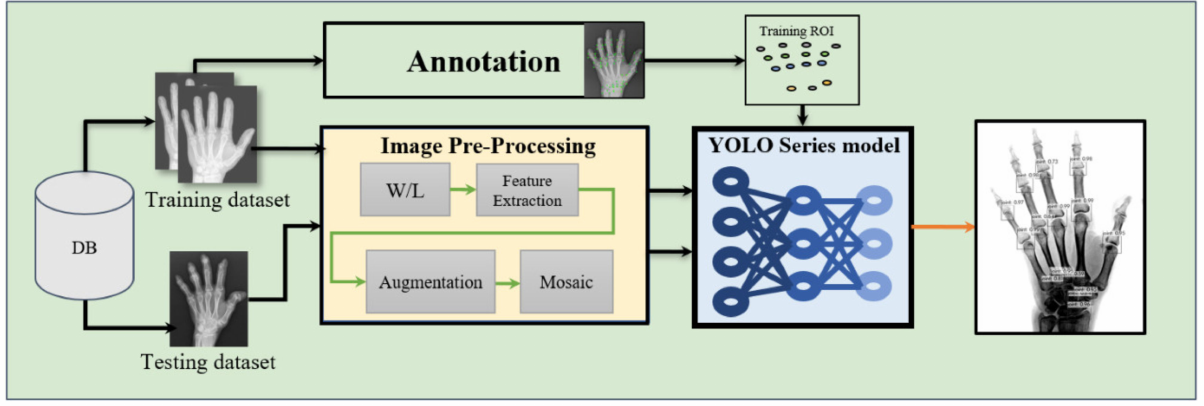
Figure 4. The image processing pipeline for RA using YOLO series